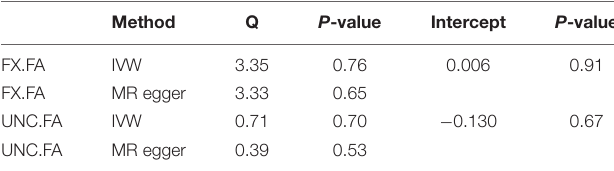
TABLE 2 | Sensitivity analysis between WM and glaucoma.